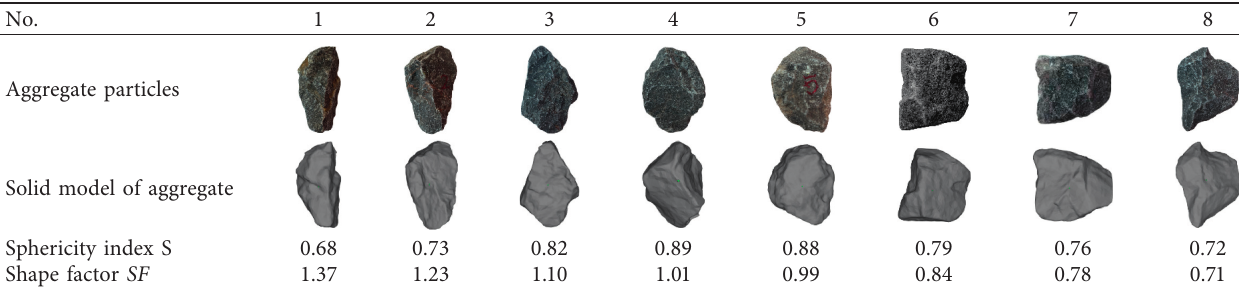
Table 6: Evaluation of the shape characteristics of typical aggregate samples.